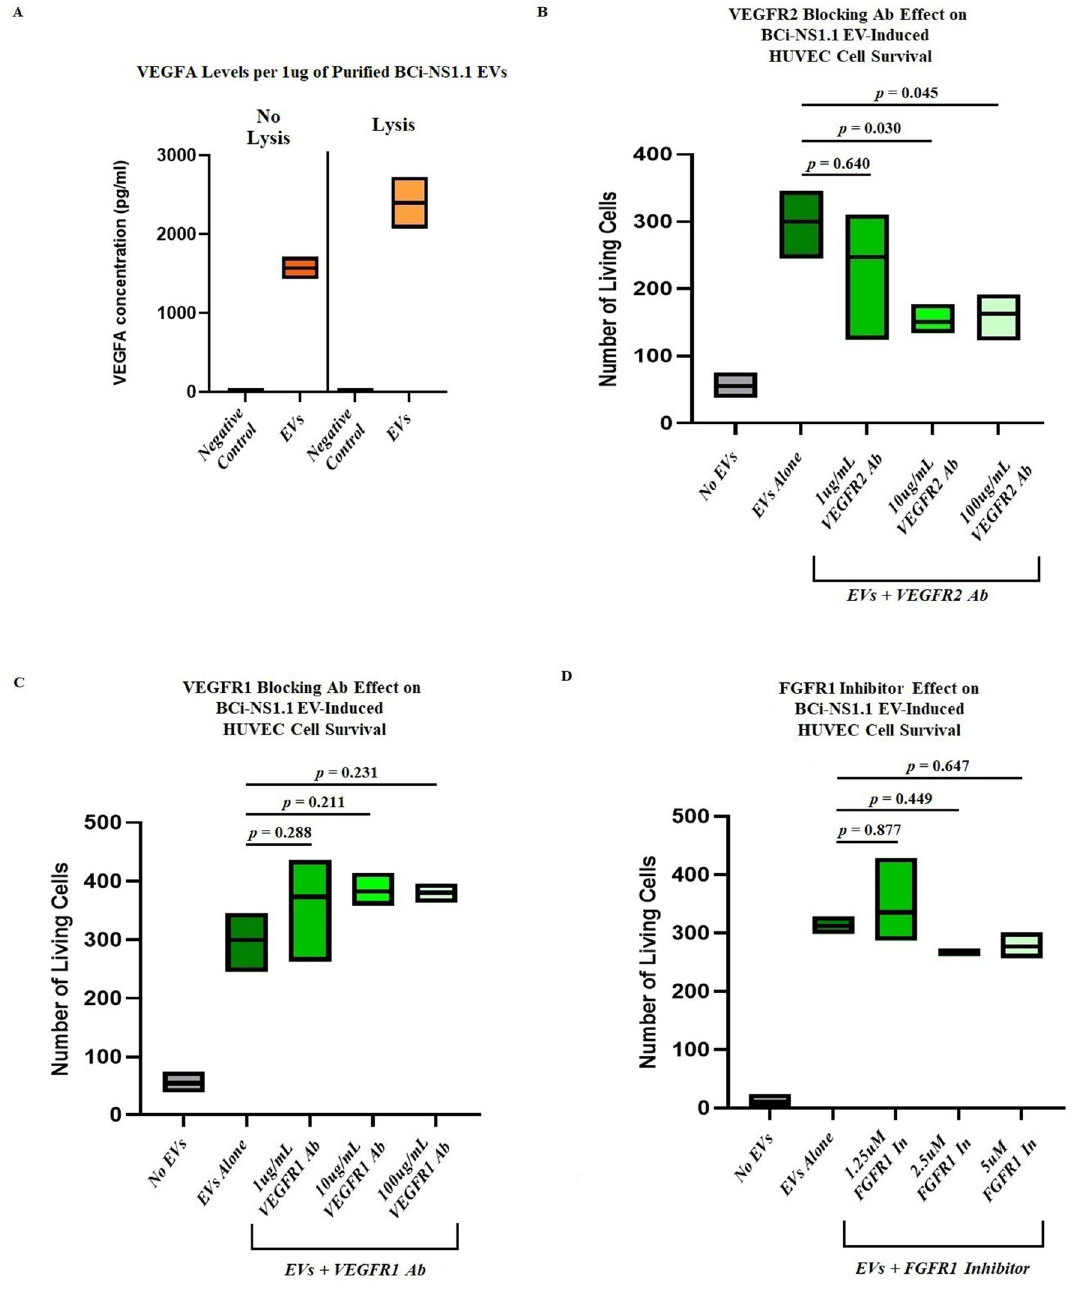
Figure 4. VEGFR2, but not VEGFR1 or FGFR1, is involved in human airway basal cell EV–mediated survival of HUVECs. ( A ), Results of ELISAs, showing the presence of VEGFA in EVs isolated from BCi-NS1.1 cells. Negative control, an equal volume of a preparation from BEGM without BPE incubated for 48 h in flasks without cells and then processed by means of the same procedures used to isolate EVs. The floating bar graphs depict results from 3 batches of isolated EVs, with each batch run in duplicate. The horizontal lines inside the floating bars represent the mean concentrations from the 3 batches. The ELISAs were also performed after EVs were incubated with RIPA buffer to lyse them open. VEGFA was detected both with and without lysis. B–D , Floating bar graphs of the numbers of living HUVECs counted after 48-h incubation with either no EVs or 10 µg/mL EVs from BCi-NS1.1 cells in the presence of increasing concentrations of ( B ) VEGFR2-blocking antibody IMC-C11, ( C ) VEGFR1-blocking antibody IMC-18F, and ( D ) FGFR1 small-molecule inhibitor SSR128129E. The horizontal lines inside the floating bars represent the means of 3 experiments; adjusted P values correspond to differences between the bars on either end of the horizontal line below them and were calculated using Dunnett’s multiple comparisons test, with P ≤ 0.05 considered statistically